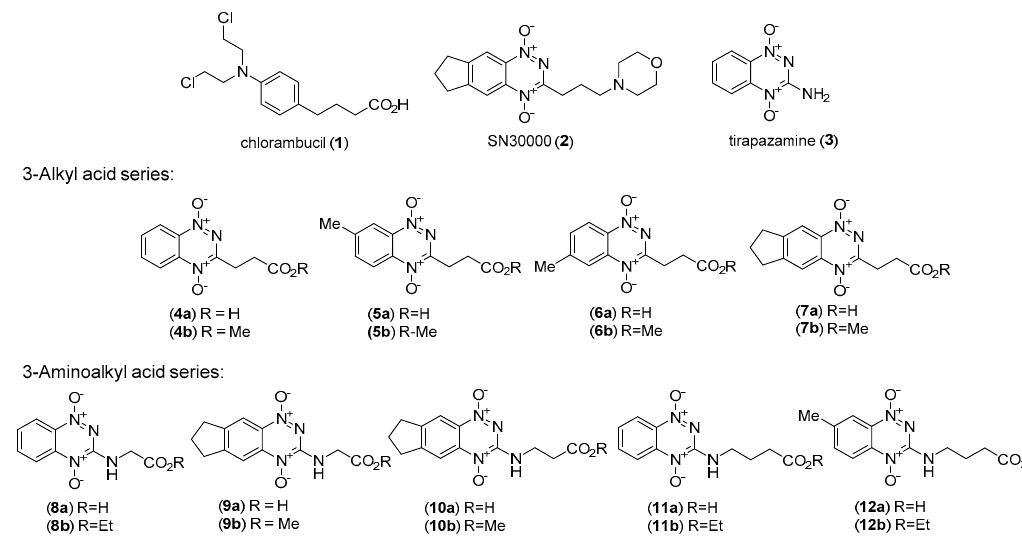
Figure 1. Reference compounds and benzotriazine di-oxide (BTO) alkanoic acids and esters based on SN30000 ( 2 ) and tirapazamine ( 3 ).